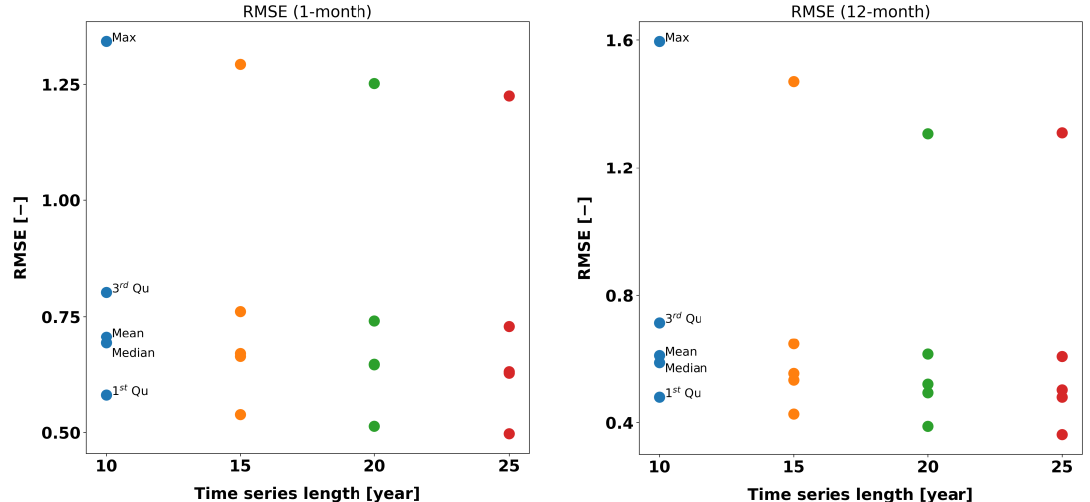
Figure 8. Comparison made between SPEI estimated using shorter and above 30 years of water balance data. Shown are the first quartile (1st Qu.), median, mean, third quartile (3rd Qu.), and maximum (Max.) of the NSE, Pearson correlation (Pearson cor.), and root mean square error (RMSE)